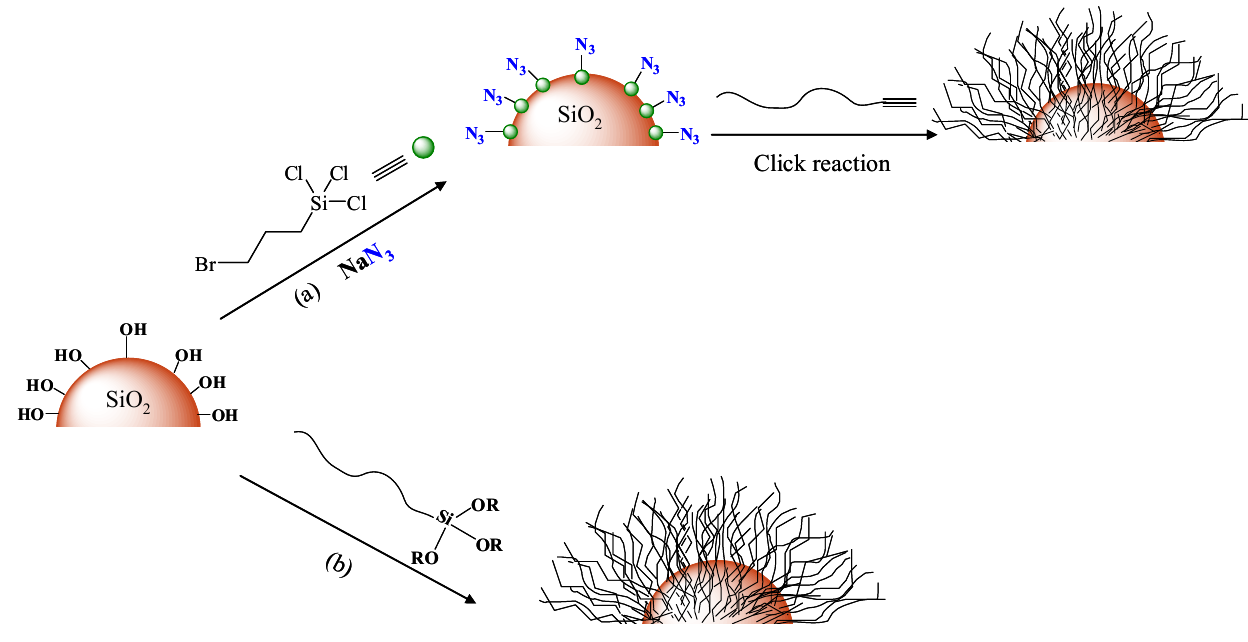
Figure 1. Schematic representation of the synthetic procedure followed for the grafting of polymer chains onto the surface of silica particles via the “grafting to” approach using click chemistry (a) and silane coupling